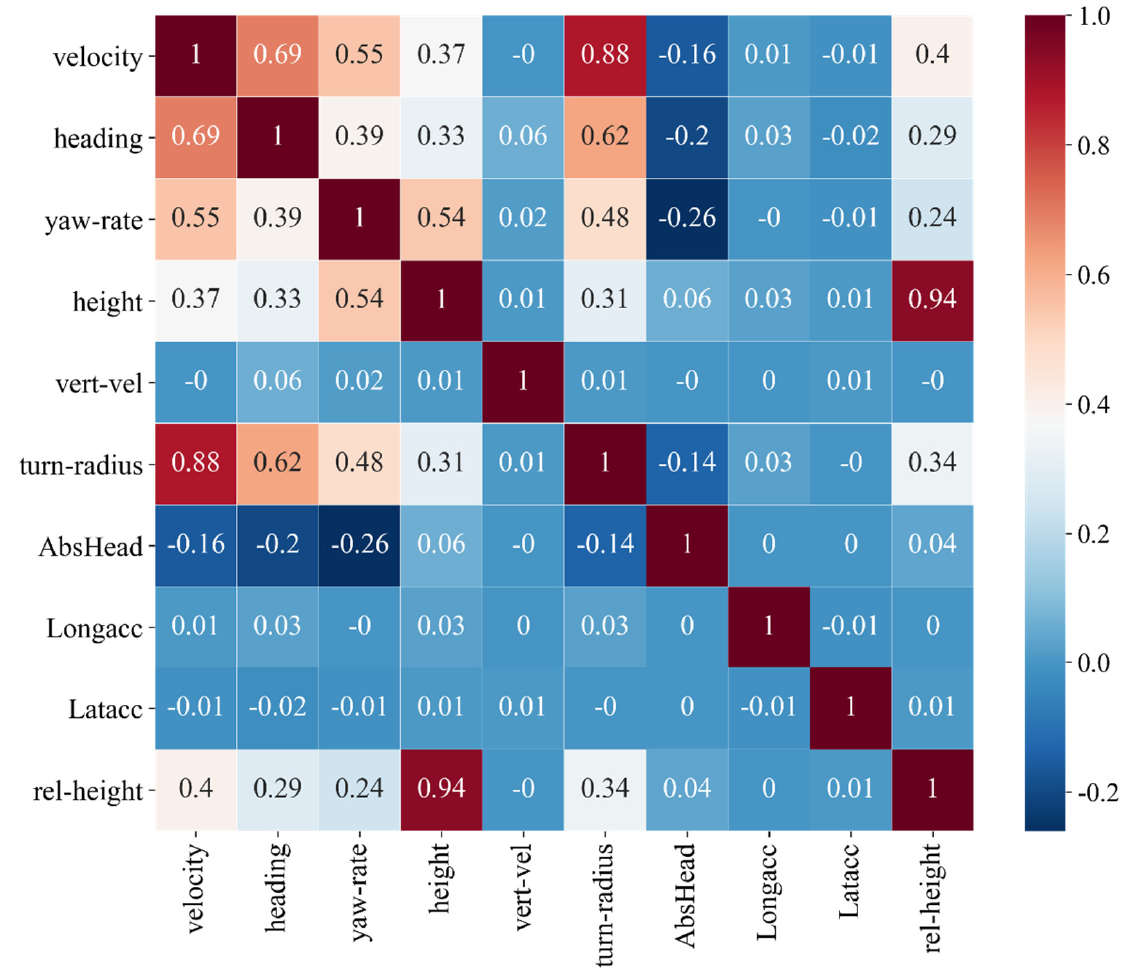
Figure 2. Correlation analysis of vehicle kinematic data.